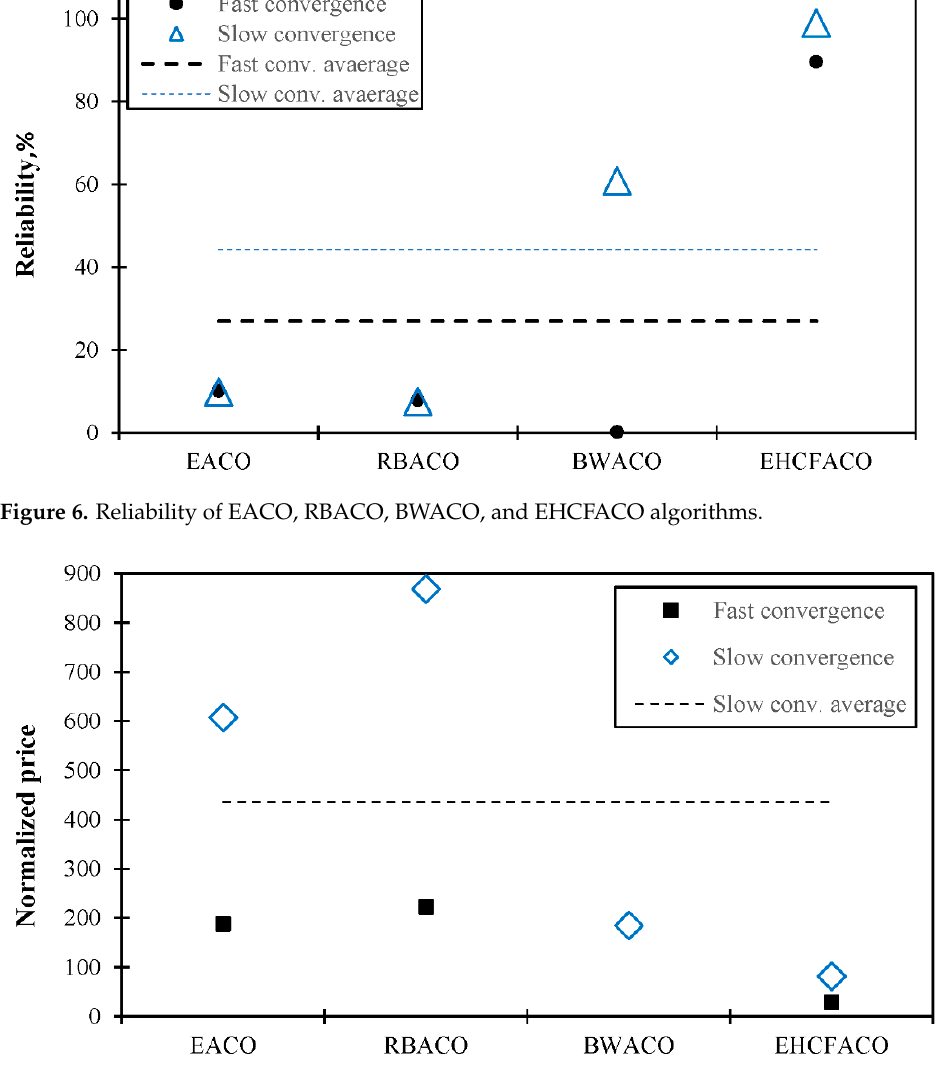
Figure 7. Normalized price of EACO, RBACO, BWACO, and EHCFACO algorithms solutions.